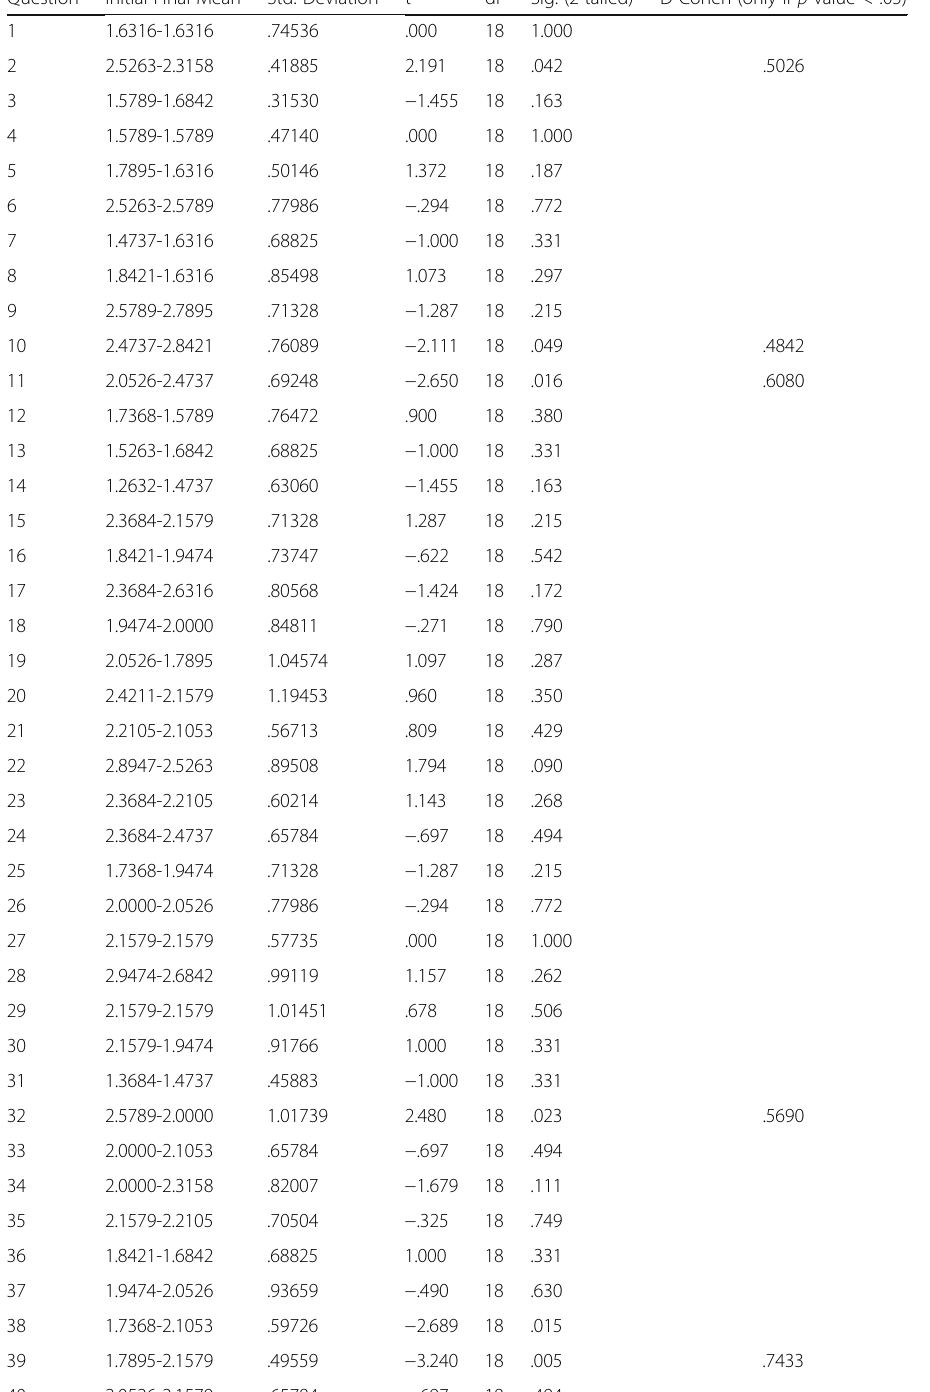
Table 3 Comparison between initial and final listening strategic behaviour by the CONTROL GROUP. Paired-Samples T